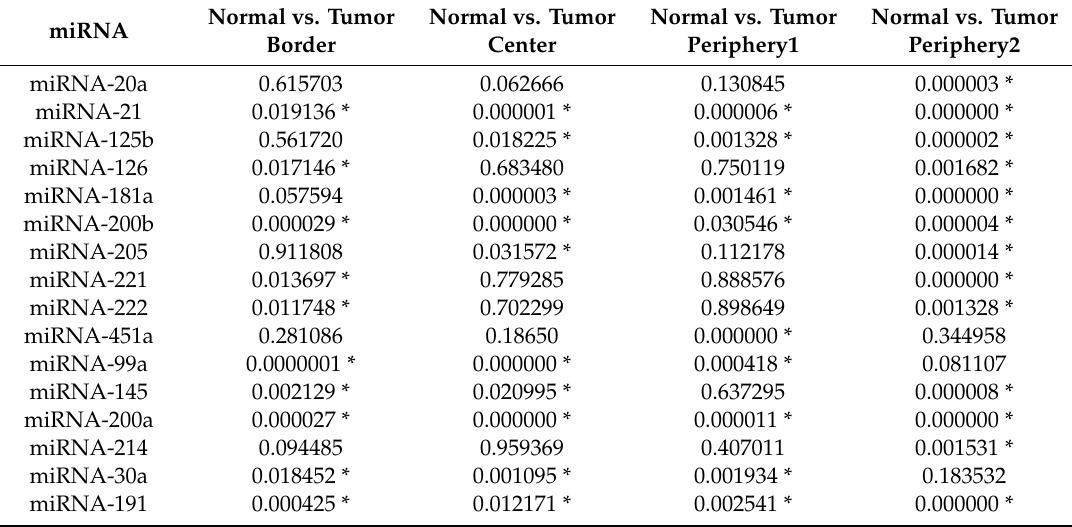
Table 2. Significance level of di ff erences in miRNA expression levels between normal ( n = 33) and di ff erent intratumor areas ( n = 132).